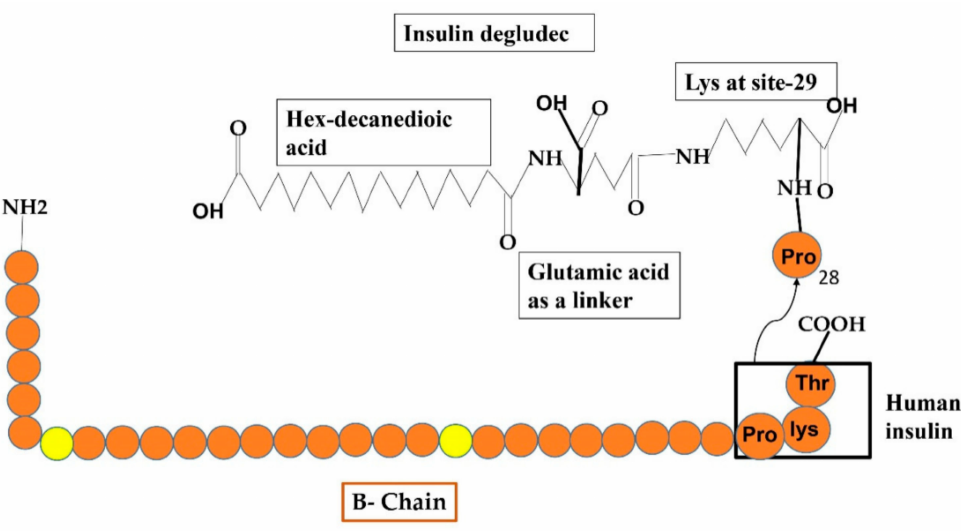
Figure 7. Reveals the formulations of Degludec insulin analog by the addition of some additional structures such as hex-decanedioic acid through Glu-linker is added to lys-29 of the B-chain of human